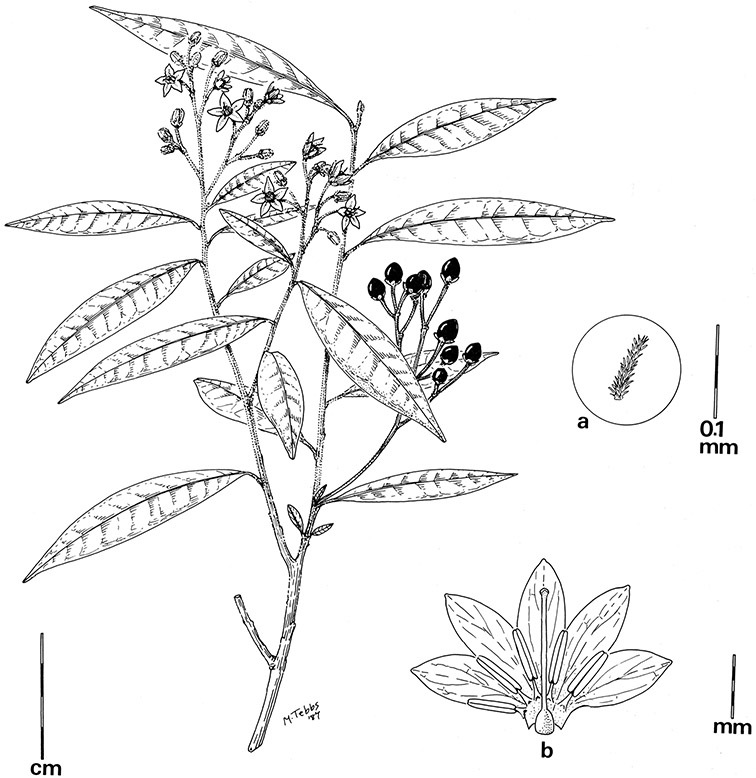
Solanum storkii C.V.Morton & Standl. (A–B drawn from Heiser 3489). Reproduced from Knapp (1989) with permission of the Natural History Museum Botany Library. Illustration by Margaret Tebbs.